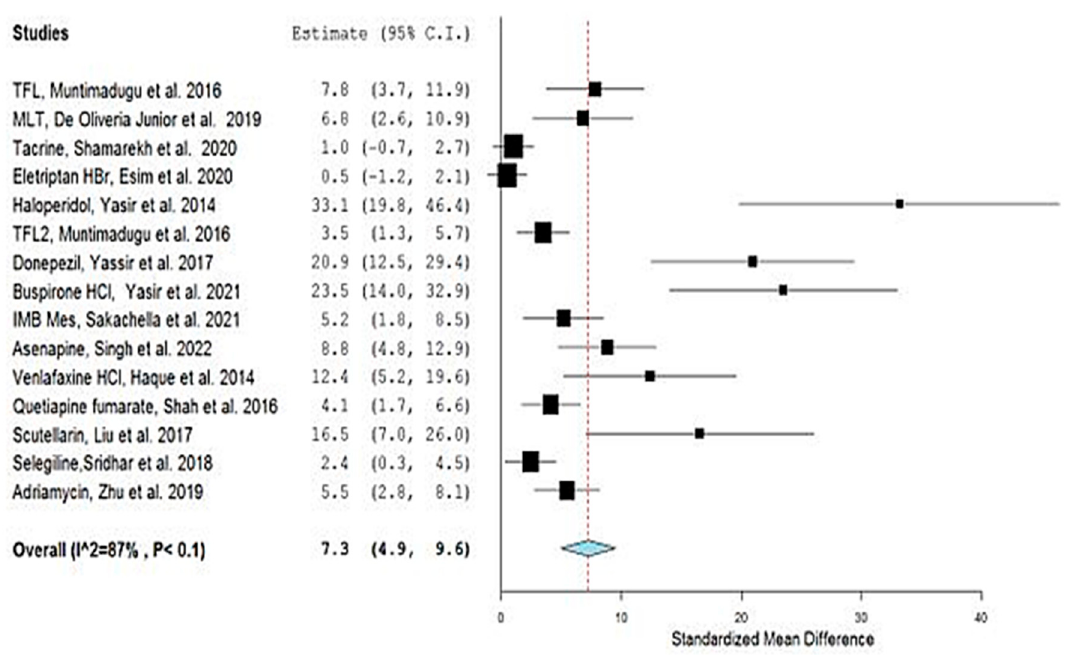
Figure 5. Forest plot of optimized meta-analysis for the studies: [1–3,5–8,11–17,19], according to Review Manager software.